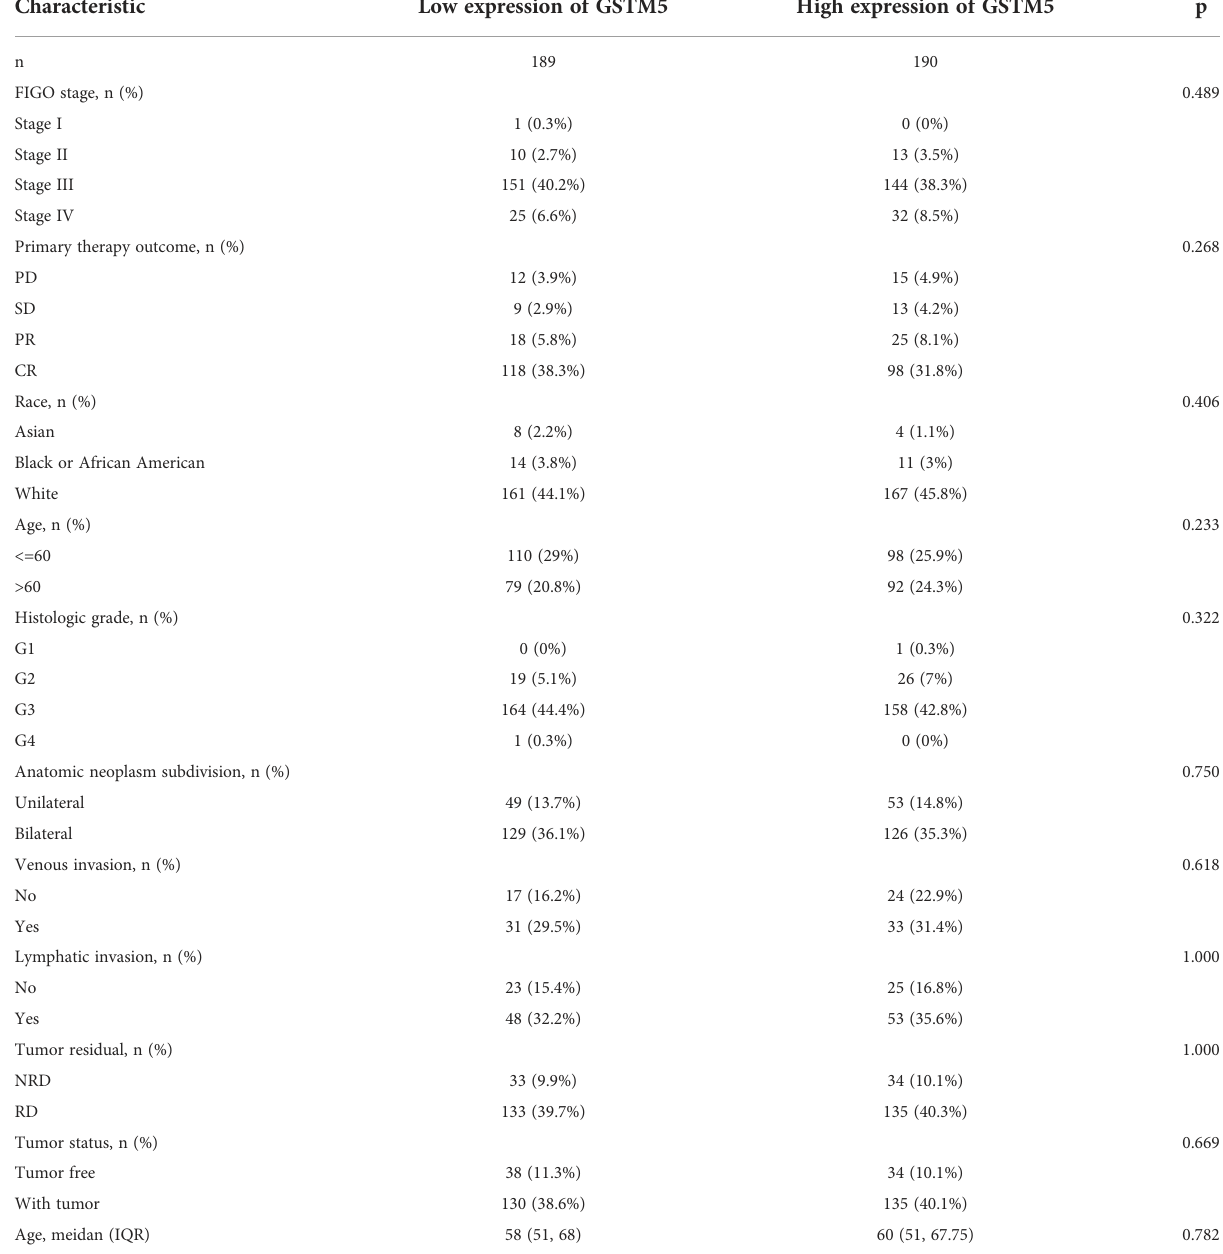
TABLE 5 The correlation between pathological parameters and GSTM5